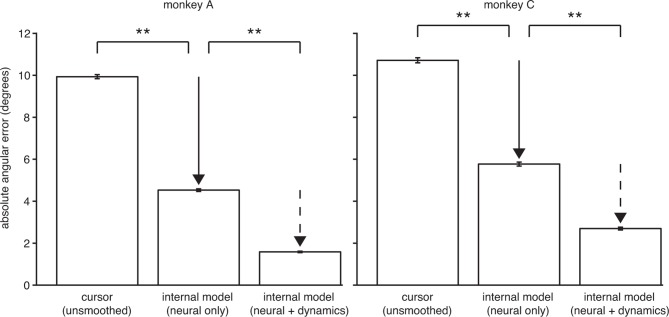
The explanatory power of IME comes primarily from structure in the high-dimensional neural activity.IME explains cursor errors by identifying two main types of statistical structure in the data. The two types of structure are (i) temporal structure in the dynamics of low-dimensional velocities (v~t), and (ii) hidden, task-appropriate structure in the high-dimensional neural activity (utraw). Here we asked to what extent each type of structure contributes toward IME’s overall explanatory power. In the internal model of Equation 10, A~v summarizes temporal dynamics in the low-dimensional velocity predictions, including how velocity feedback informs internal predictions of cursor state and the degree of temporal smoothness across internal velocity predictions within a single whisker. Intended velocity tends to be similar from one timestep to the next, and whiskers with the appropriate temporal structure (as determined by fitting A~v to the data) can explain a portion of cursor movement errors. The internal model parameters B~v and b~v reveal features in the high-dimensional neural activity that are consistent with straight-to-target movement intent and that are often not reflected in the BMI cursor movements. To determine the relative contribution of structure in the high-dimensional neural data toward the explanatory power of IME, we devised a constrained variant of IME that relies entirely on the high-dimensional neural activity to generate whiskers. Specifically, we constrained A~v=0 in Equation 6, removing IME’s ability to leverage velocity dynamics within its whiskers while preserving its ability to identify structure in the high-dimensional neural activity (since no constraints are placed on B~v). In this constrained IME variant, termed “neural-only” IME, the subject’s internal prediction of the velocity resulting from neural command utraw is simply v~tt=B~v⁢utraw+b~v. Because neural-only IME does not incorporate temporal smoothing of velocity predictions, it cannot be directly compared to the BMI mapping via the cursor error presented in Figure 3C, which was computed using smoothed cursor velocities. To enable fair comparison with the BMI mapping, we computed cursor errors using single-timestep (unsmoothed) velocity commands, vtraw=Bv⁢utraw+bv (replicated from Equation 8). Here we compared the angular errors of these v~tt (“neural only”) and vtraw (“unsmoothed cursor”). Internal models extracted using neural-only IME explain 54% and 46% of unsmoothed cursor errors in monkeys A and C, respectively, demonstrating that there is considerable structure in the high-dimensional neural activity. For reference, we also include the error from unconstrained IME (i.e., by fitting A~v to the data; “neural + dynamics”; replicated from Figure 3C). In this view, the large difference between unsmoothed cursor errors and neural-only internal model errors (solid arrow) represents the explanatory power of the structured high-dimensional neural activity without applying any temporal smoothing and without leveraging visual feedback of cursor velocity. The smaller difference between errors through the neural-only internal model and the unconstrained internal model (dashed arrow) demonstrates the additional explanatory power gained by incorporating velocity feedback and temporal smoothing. As in Figure 3C, angular error was defined as the angle by which the cursor would have missed the cursor-target overlap zone had it continued in the direction of vtraw (BMI mapping) or v~tt (internal model) from position p~tt or pt, respectively (i.e., Θp in Figure 2—figure supplement 1). Absolute angular errors were first averaged within each trial, then averaged across all trials. Error bars indicate ±  SEM (**: p<10-5, two-sided Wilcoxon test; monkey A: n = 5908 trials; monkey C: n = 4577 trials).